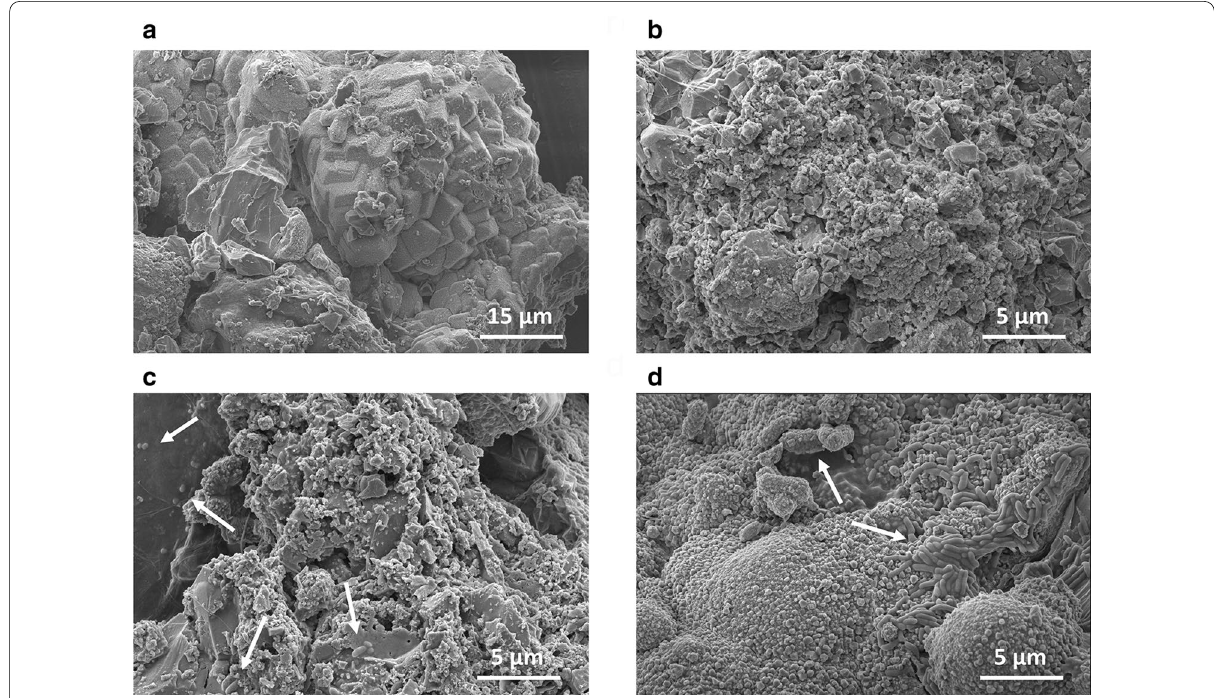
Fig. 7 FE-SEM image of calcium carbonate precipitated in the cracks of SN-treated specimens. a , b Images of calcium carbonate formed in the cracks of Ref and Oys mortars on day 14 post-crack induction. c , d Calcium carbonate and bacteria collected from the cracks of Spo and Mix mortars treated daily with SN for 14 days post-crack induction. Arrows point to vegetative cells or